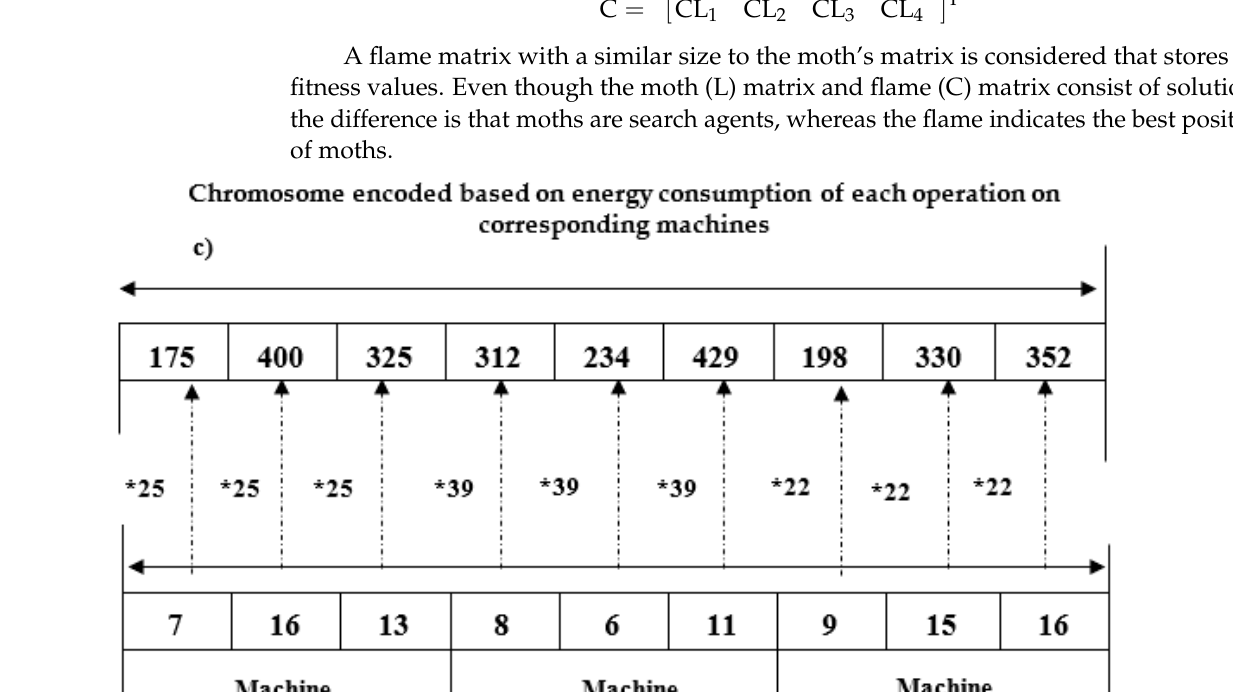
Table 6. Energy and reliability data.